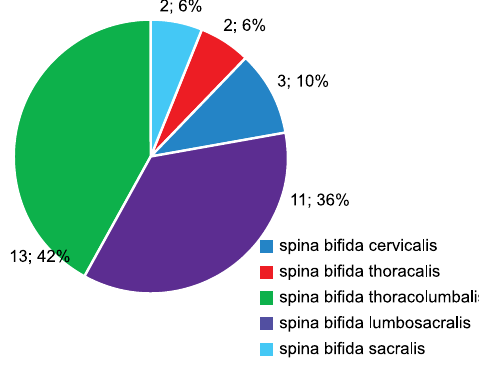
FIGURe 2. frequency of particular localizations of spina bi-